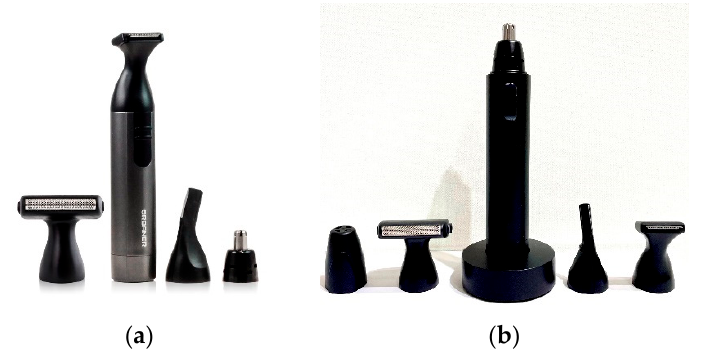
Figure 8. Wet/dry 4-in-1 groomer for men. ( a ) Battery- operated type; ( b ) Rechargeable type.